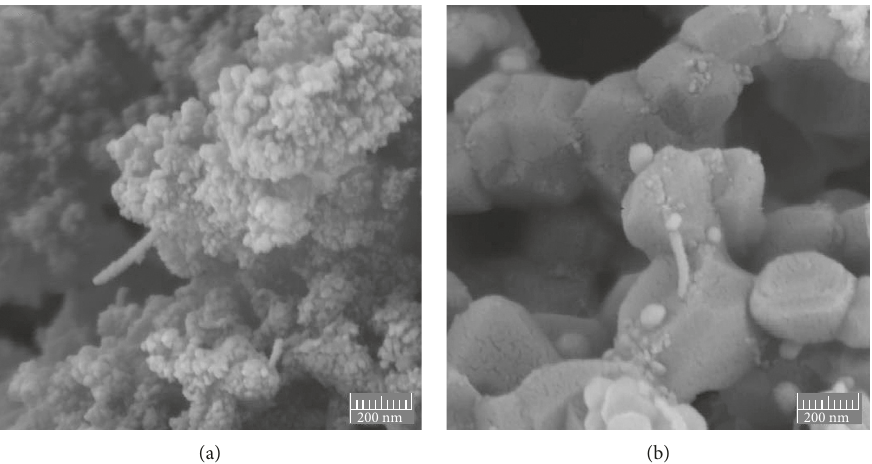
Figure 3: FEG-SEM images of core/shell structures of TiO and (b) 1000 ° C.